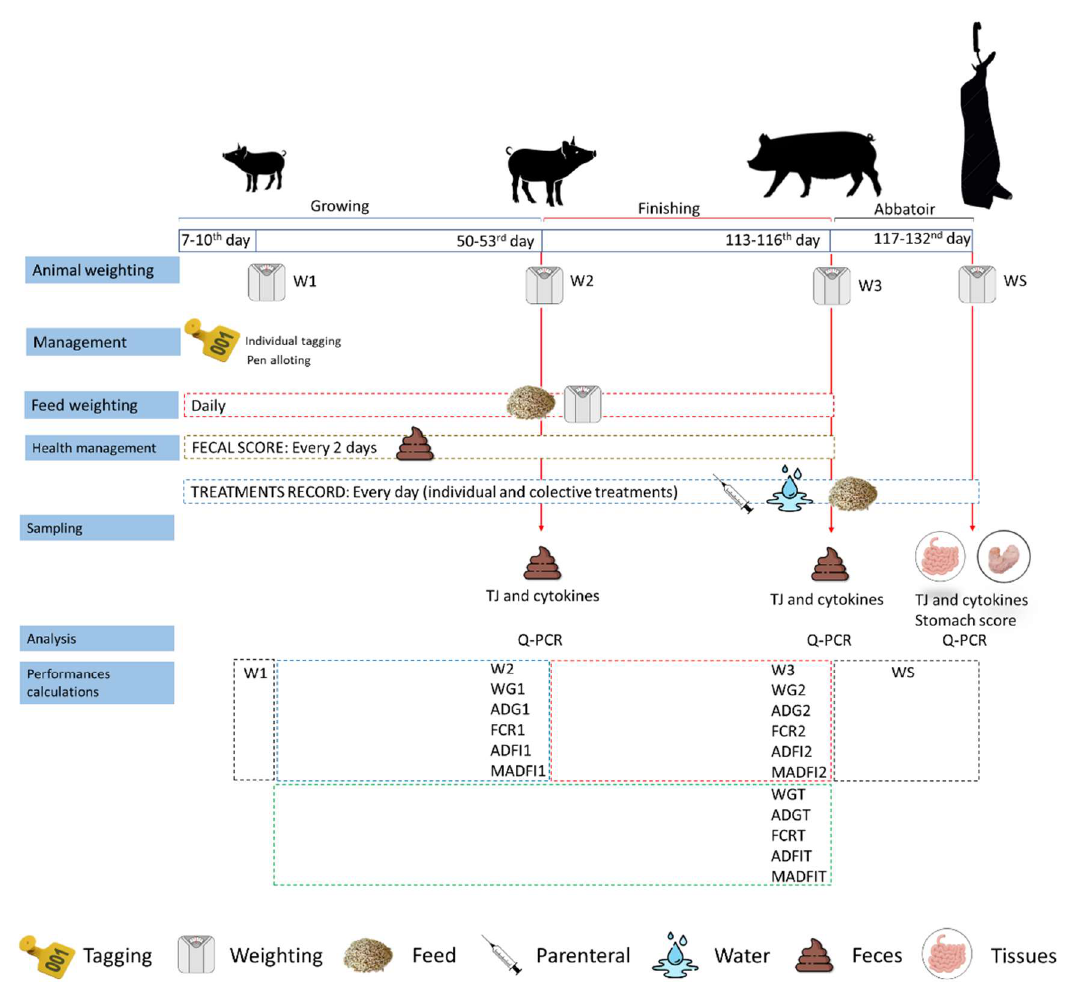
Figure 1. Summary of the methods used in the case–control test, including specific handling, animal and feed weighing, fecal and tissue sampling, monitoring of clinical status, laboratory tests developed, and performance parameters calculated.